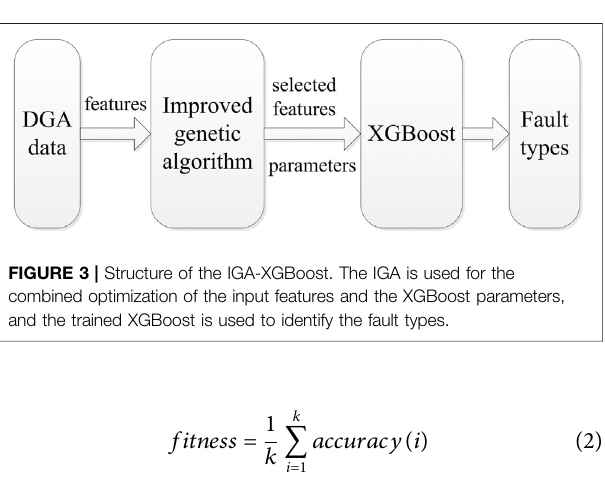
Frontiers in Energy Research |